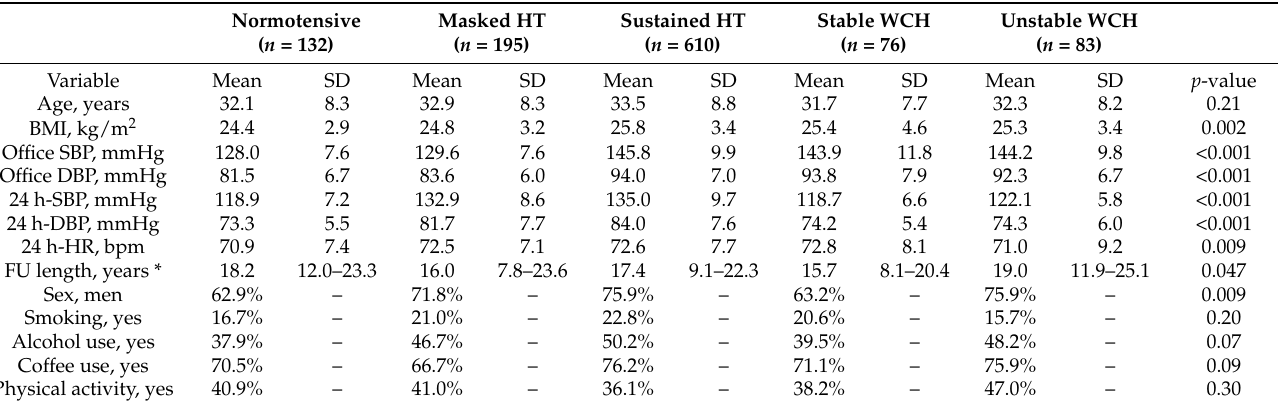
Table 1. Clinical characteristics of the 1096 participants by BP status assessed three months after